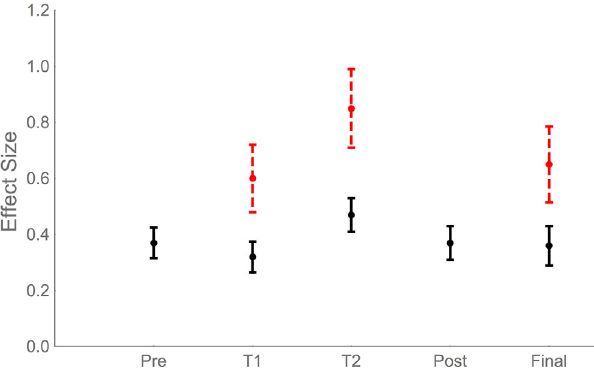
FIG. 8. Comparing blue and green students. Cliff ’ s δ (solid black) and Cohen ’ s d (dashed red) for the precourse FCI (Pre), the first term test (T1), the second term test (T2), the postcourse FCI (Post), and the final examination